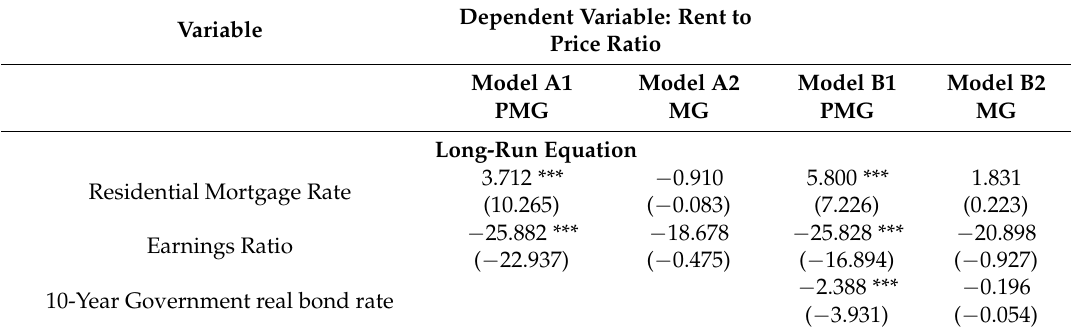
Table 3. Comparison between pooled mean group (PMG) estimation and mean group (MG)